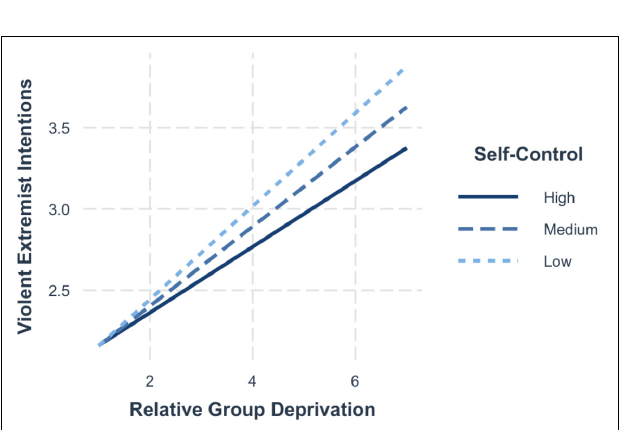
FIGURE 8 | Simple slopes for group deprivation and critical thinking on violent extremist